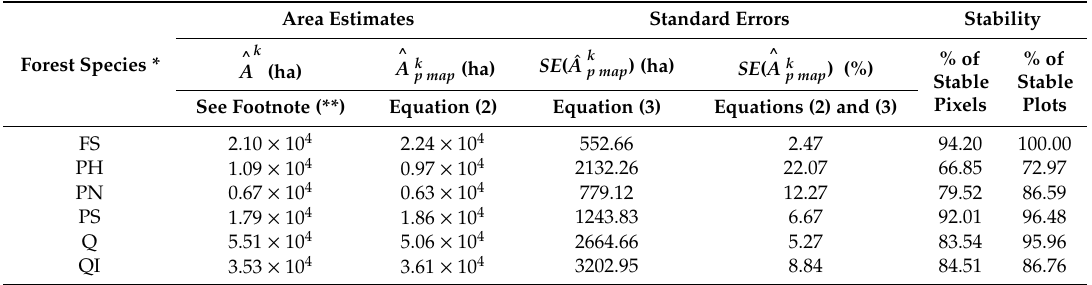
% of % of Stable Stable Pixels